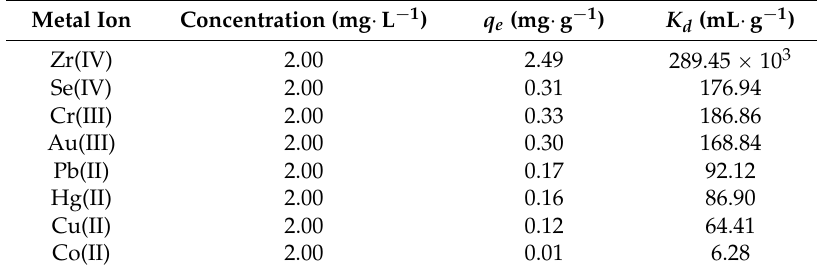
Table 1. Study of selectivity of 20.0 mg SG-APTMS-N,N-EPANTf 2 towards various metallic cations.